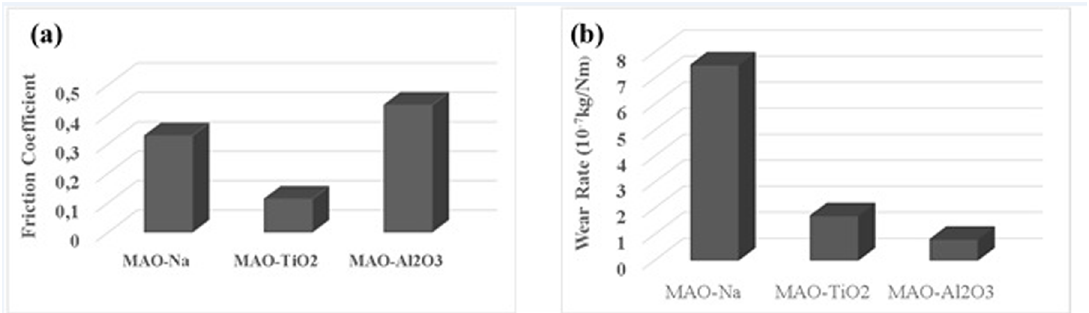
, MAO-Al O samples of (a) Friction coefficient (b) Mass wear 2 2 3